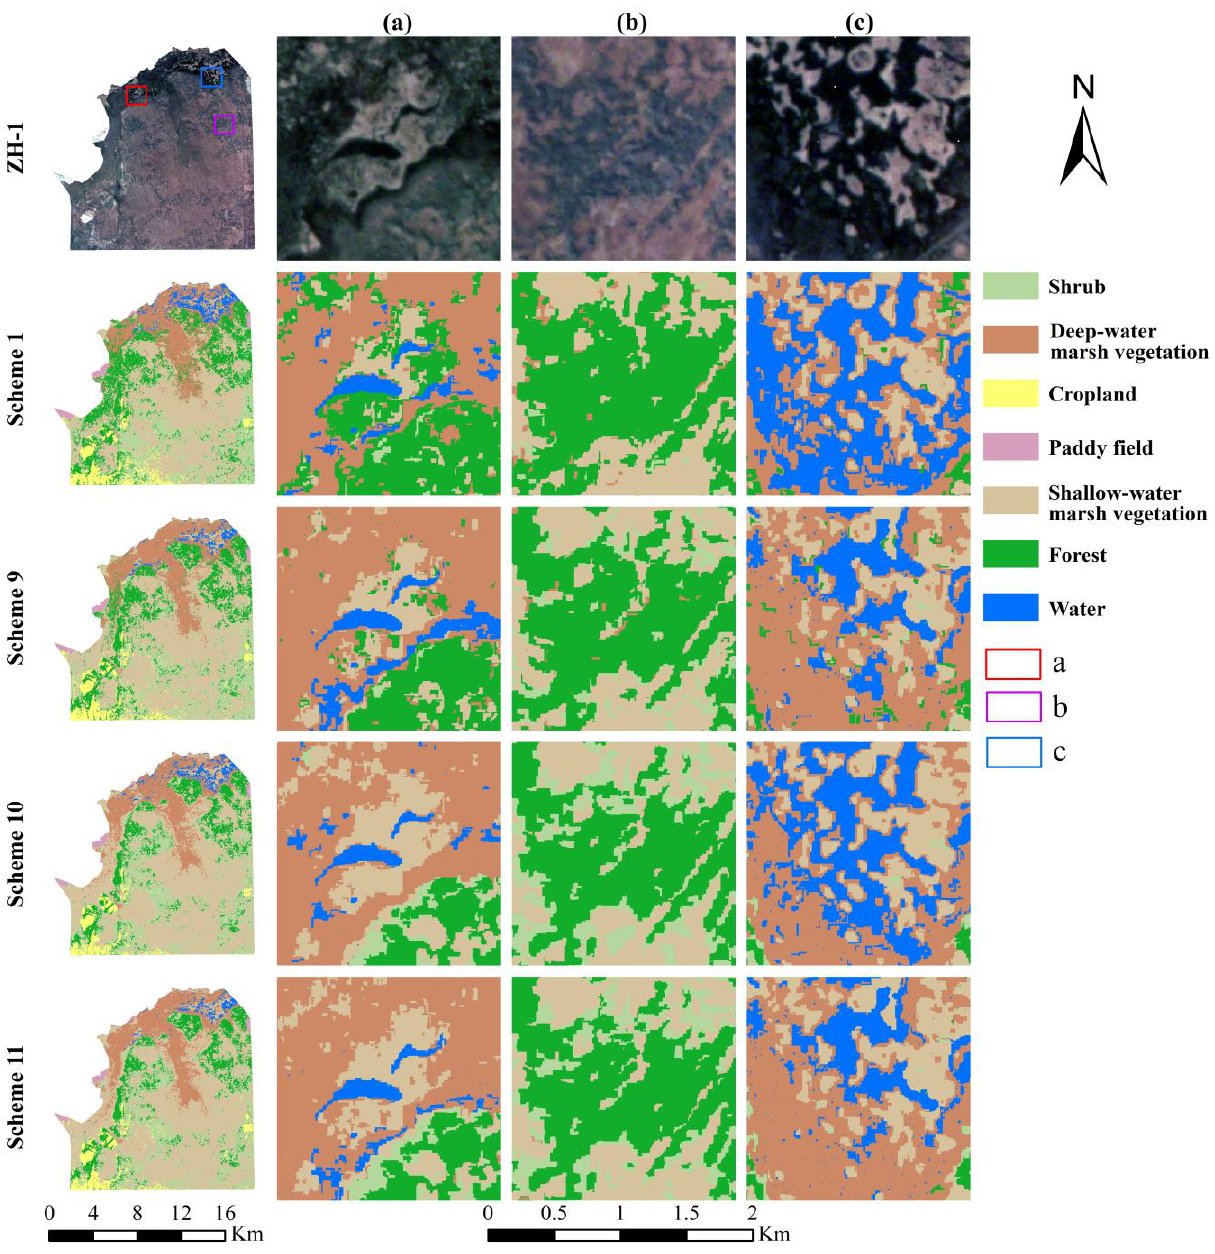
Figure 5. Classification results of integrating hyperspectral and quad-polarization SAR images using the optimal classifiers. ( a ) Water, deep-water and shallow-water marsh vegetation; ( b ) Forest and shrub; ( c ) Water and deep-water marsh vegetation.